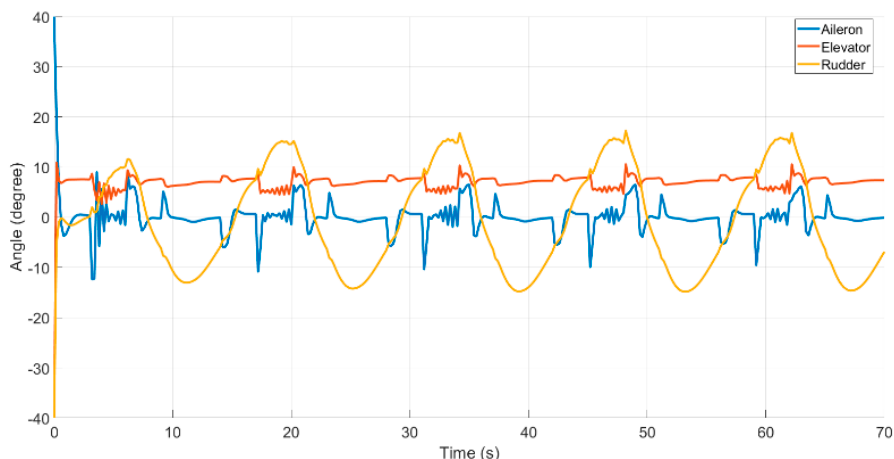
Figure 16. The control surfaces change during the dynamic soaring.